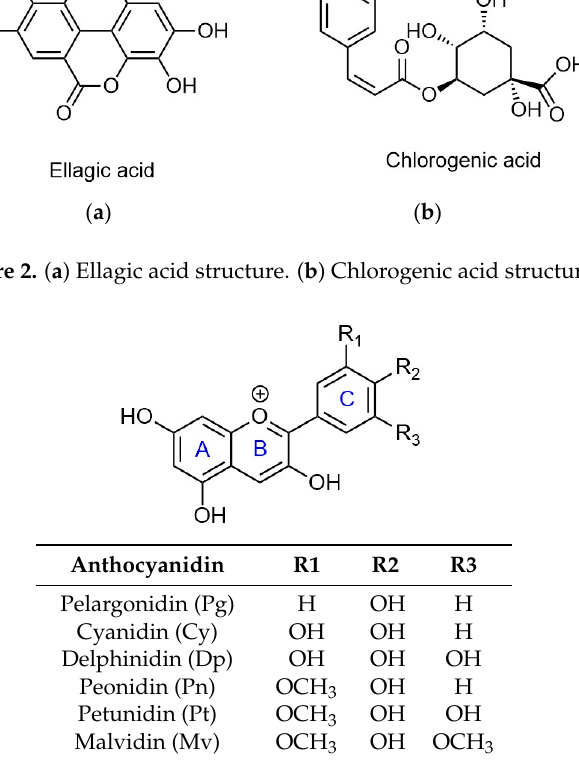
Figure 1. ( a ) Ellagic acid structure. ( b ) Chlorogenic acid structure.